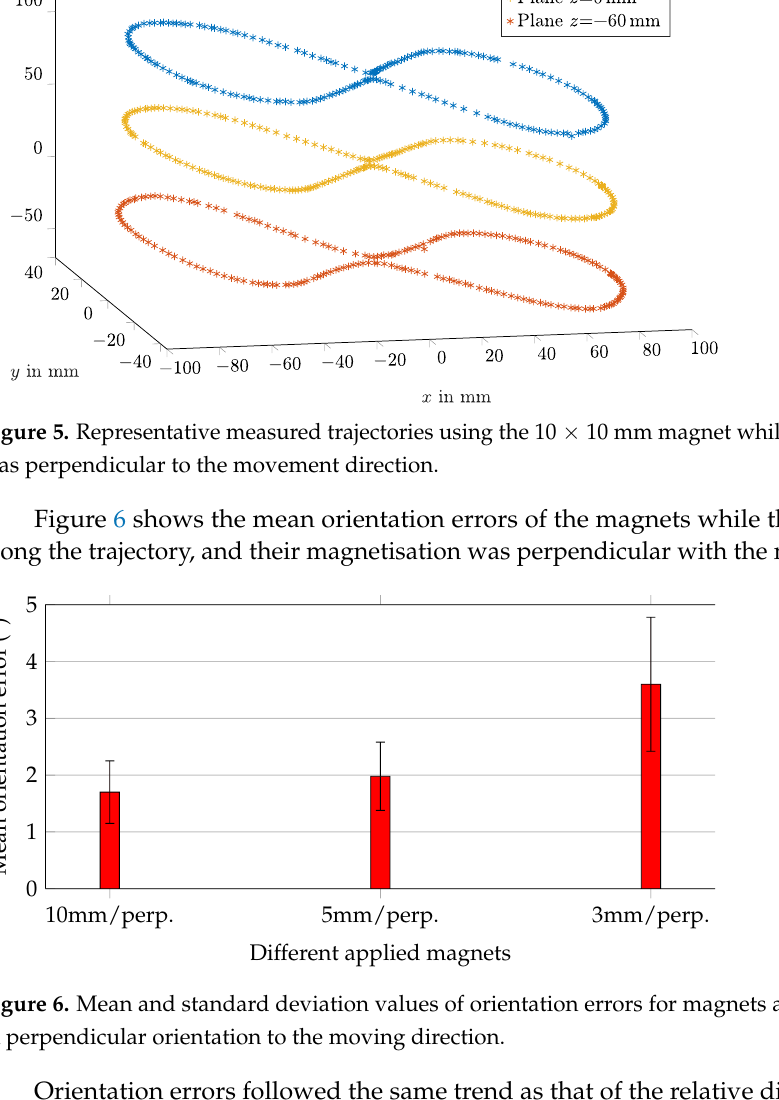
Figure 6. Mean and standard deviation values of the orientation errors for the magnets along the trajectory in perpendicular orientation to the moving direction. in perpendicular orientation to the moving